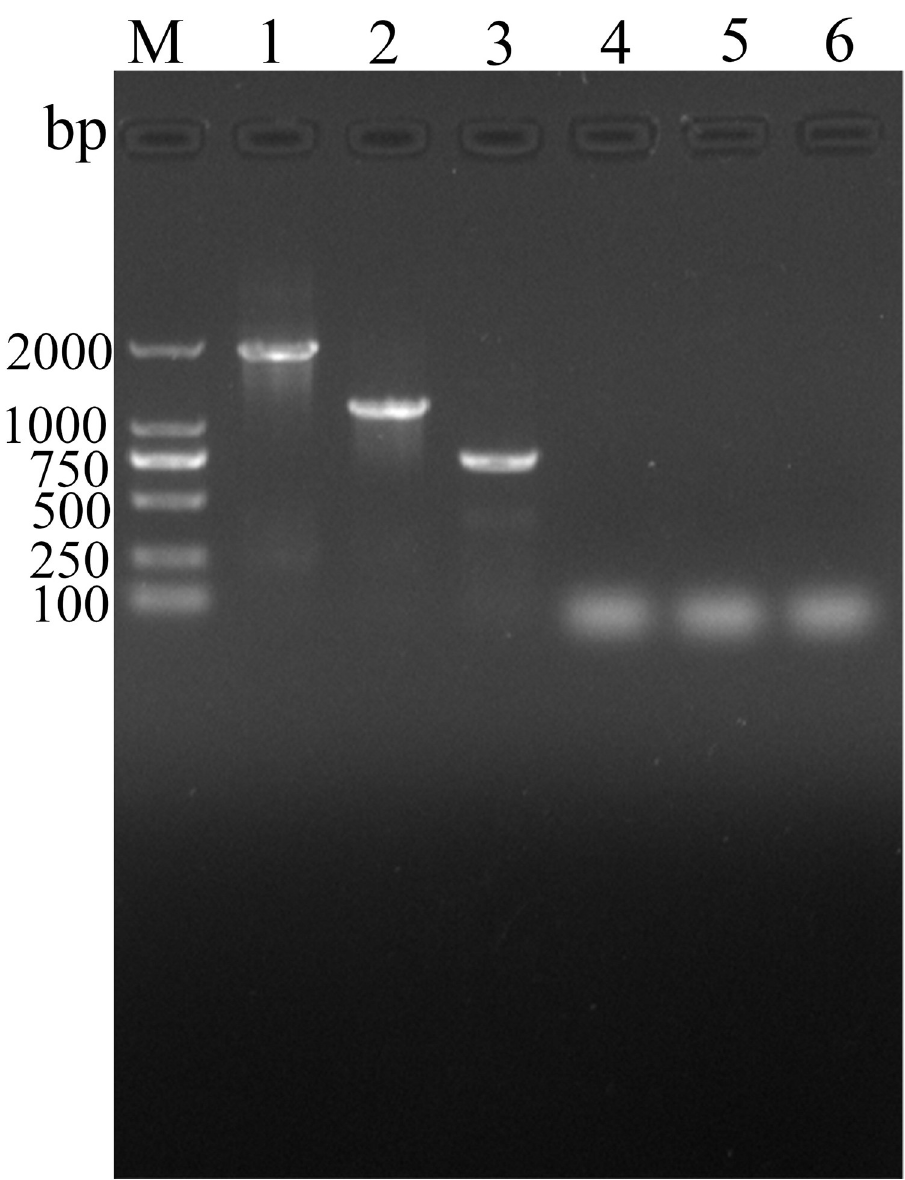
Fig 2. PCR identification of recombinant plasmids. Lane M: DNA marker. Lane 1: PCR product of pcDNA3.1-TsCRT+TsSP1.1. Lane 2: PCR product of pcDNA3.1-TsCRT. Lane 3: PCR product of pcDNA3.1-TsSP1.1. Lane 4: PCR product of pcDNA3.1 using TsCRT+TsSP1.1 primers. Lane 5: PCR product of pcDNA3.1 with TsCRT primers. Lane 6: PCR product of pcDNA3.1 with TsSP1.1 primers.